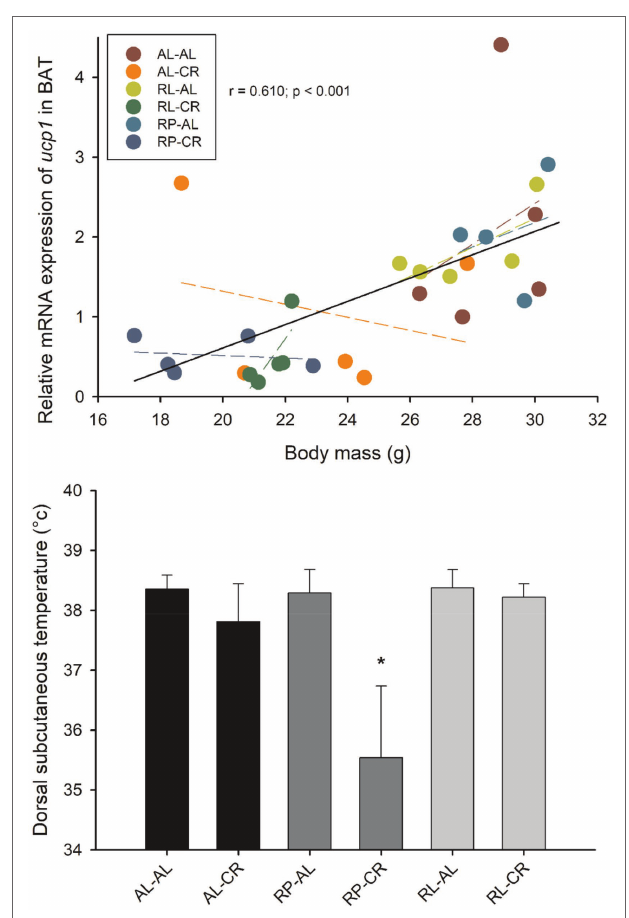
FIGURE 9 | Relationship between Ucp1 in BAT and body mass in adult male BALB/c mice, from six groups of perinatal and adult food availability. Dashed line: linear regression of each treatment. Inner graphs show subcutaneous temperature among treatments. One asterisk: p <